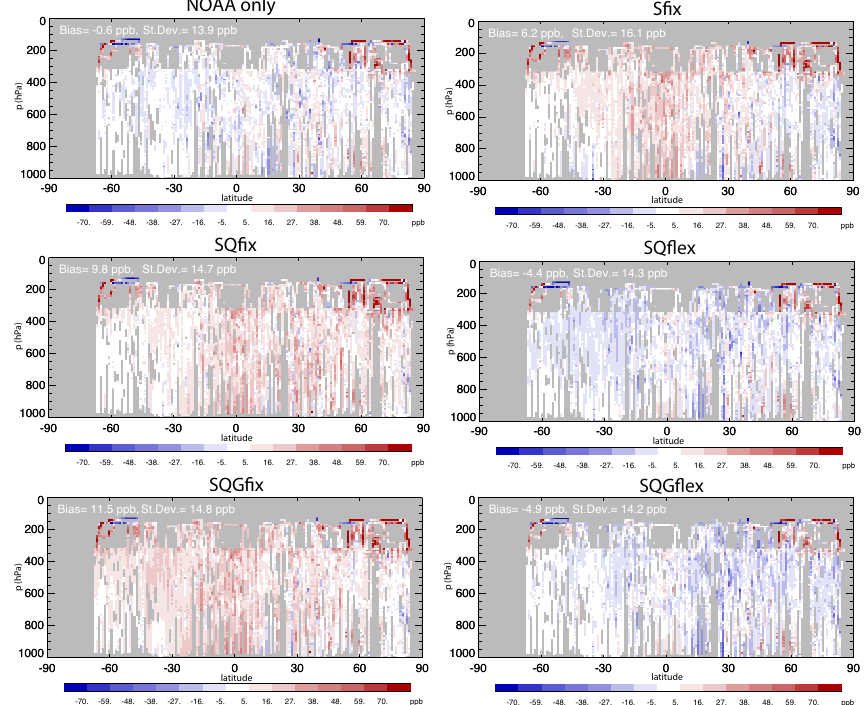
Fig. 8. Differences between simulated and observed CH 4 over the Pacific for the HIPPO measurement campaign. (Top) NOAA only and S fix , (Middle) SQ fix and SQ flex , (Bottom) SQG fix and SQG flex .